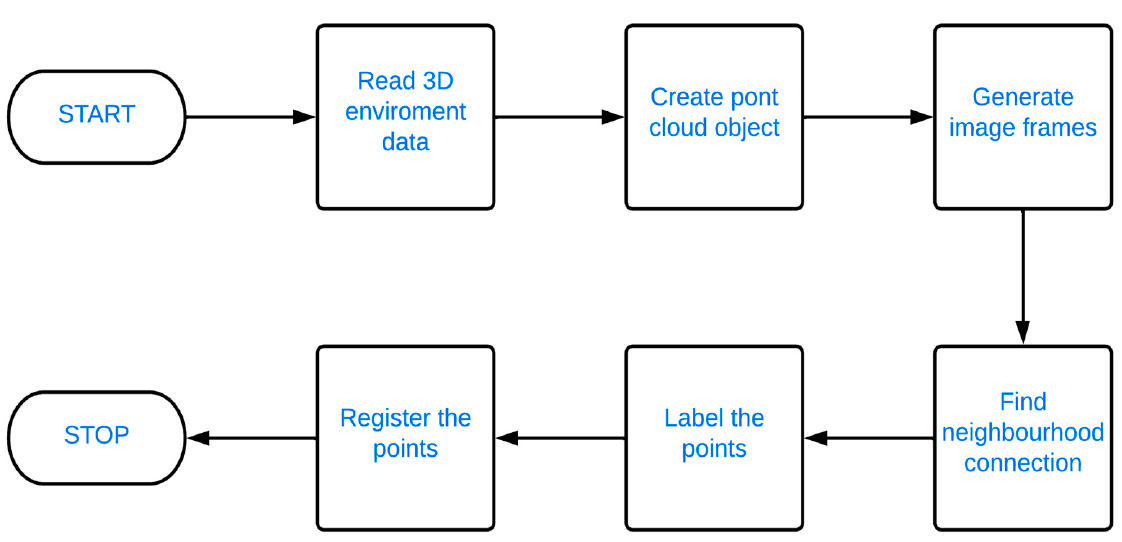
Figure 3. Workflow of Pre-Learning.